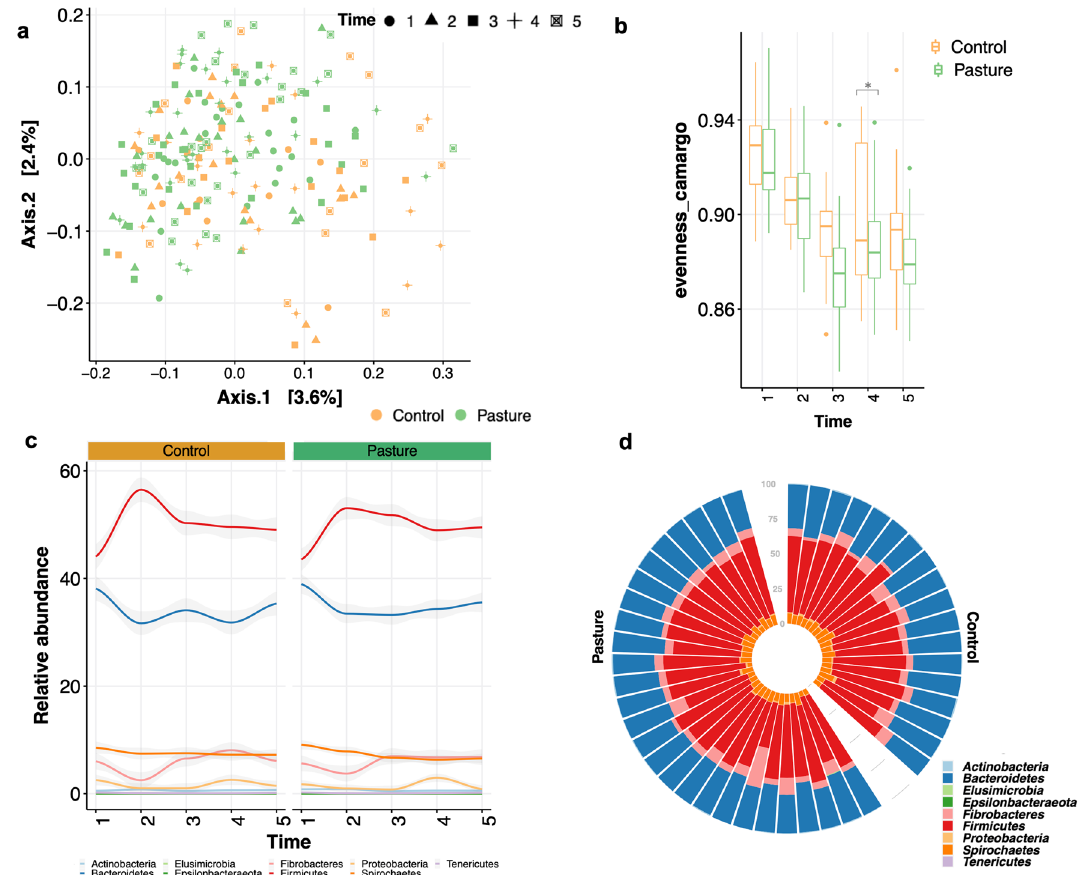
Figure 3. Description of the bacterial community diversity and the main phyla between groups. ( a ) Dissimilarities in fecal microbiota composition represented by the non ‐ metric multidimensional scaling (NMDS) ordination plot, with Bray–Curtis dissimilarity index calculated on un-scaled ASVs abundances. Samples are colored by group: pasture (green) and control (orange). The shape of dots indicates the longitudinal time point (from 1 to 5); ( b ) box plot representation of the evenness Camargo index using the rarefied ASVs table for each group and time points. The box plot features the median (center line) and interquartile range, and whiskers indicate 5th to 95th percentile; ( c ) Longitudinal evolution of the most abundant phyla of horse gut microbiota in the control and pasture groups. Graph shows relative abundance (y axis) of the most common bacterial phyla over time (x axis), averaged across control and pasture groups; ( d ) circular stacked bar plot of the main phyla for each individual in the cohort. Rare phyla such as Elusimicrobia, Verrucomicrobia and Synergistetes are not represented (mean relative abundance across groups < 0.01%). Individuals are stratified by groups. All plots were produced in R software https ://www.r-proje ct.org, using the version